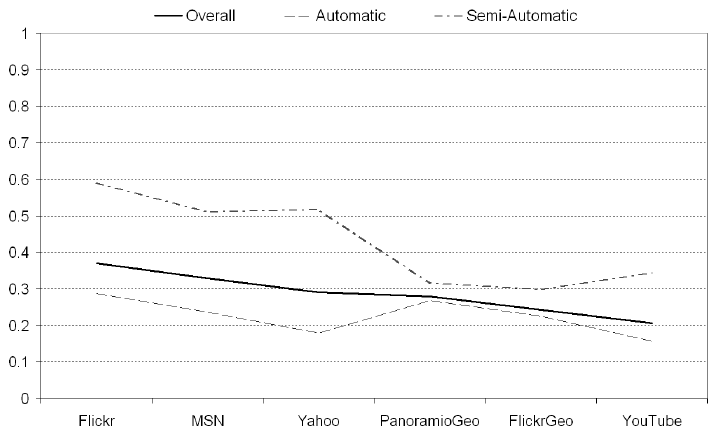
Figure 14. Effectiveness of various sources of augmented